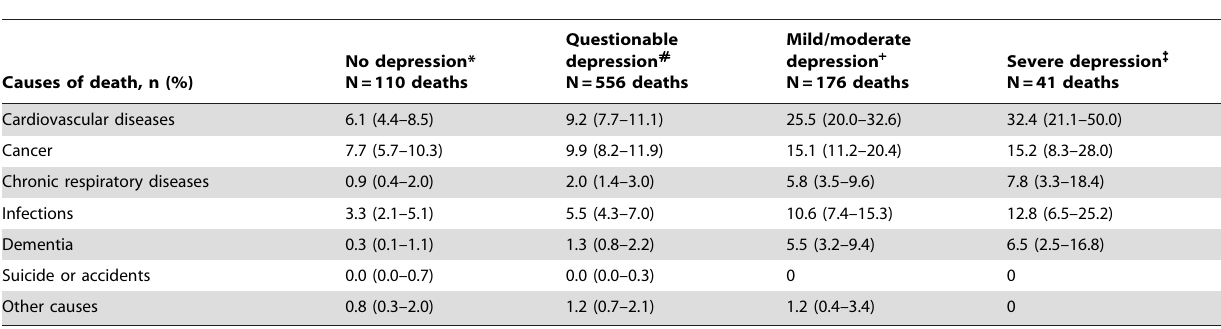
Table 3. Mortality rates (95% confidence interval) per 1,000 persons per year according to the severity of depressive symptoms at the time of